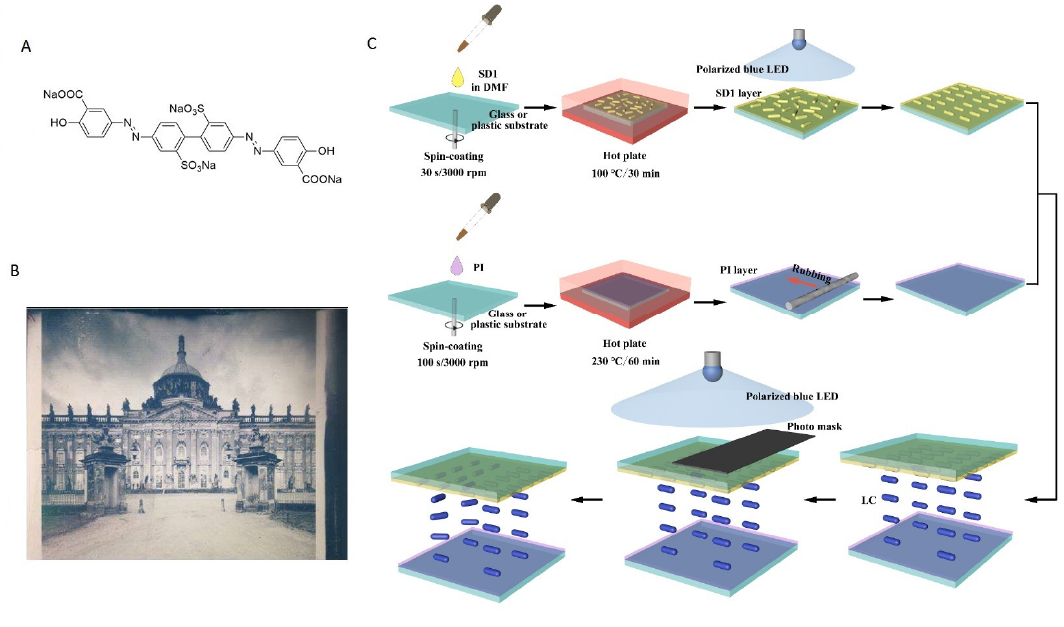
Figure 1. Structure and fabrication. ( A ) Chemical structure of the SD1 dye, which is used as the OA photo-alignment material. ( B ) The ODLCD sample with 32 grey levels ( C ) Process flow of the sample consisting of two substrates SD1 OA alignment layer and PI OP alignment layer.